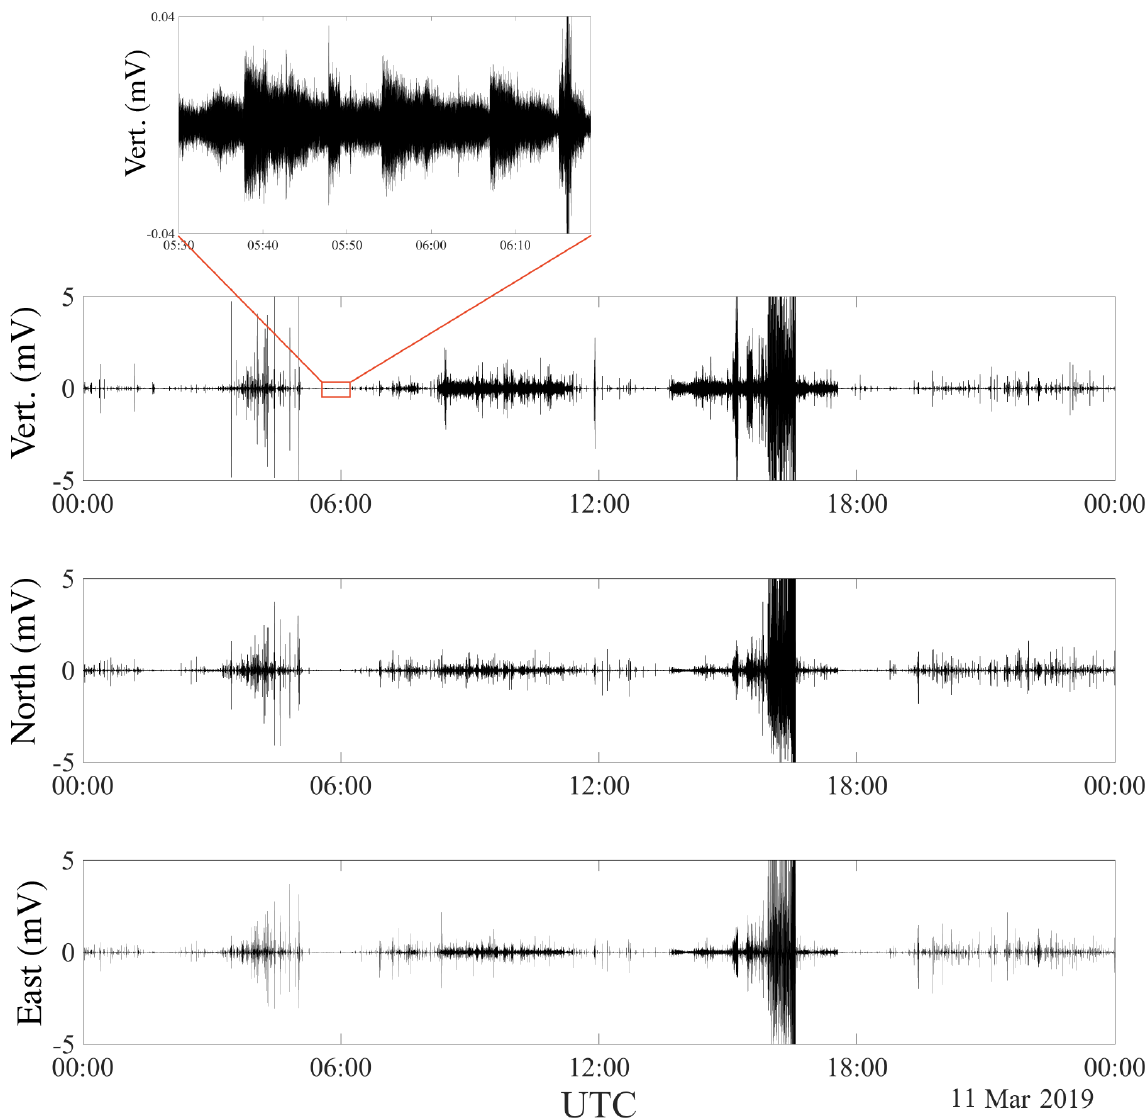
Figure 2. The three 24h waveform components of the ambient seismic field recorded on fast ice in Svalbard on 11 March 2019. The wavefield is very rich and composed of icequakes with different orders of energy magnitude, transients (see the zoomed area on the vertical channel) and anthropogenic activities (between 08:00 and